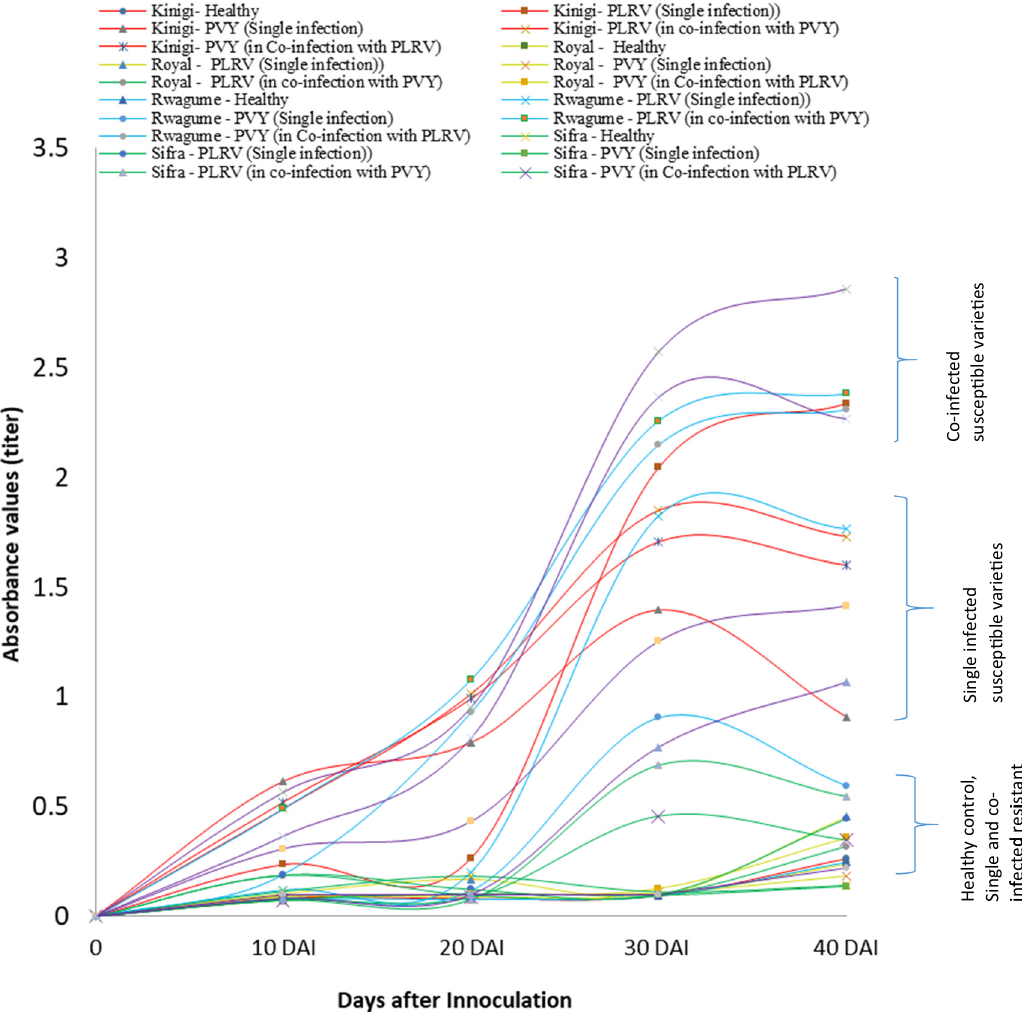
Figure 3: Relationship between viral titers for PVY, PLRV in single and mixed infection at di ff erent days after infection ( DAI ) among fi ve potato varieties. DAI = days after